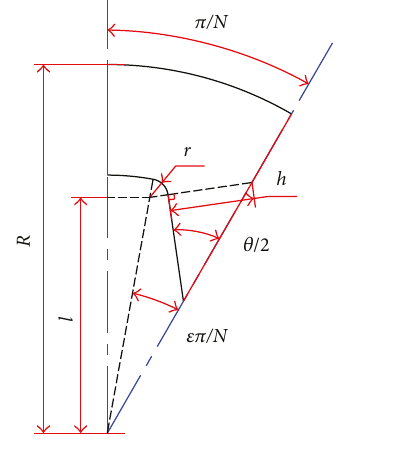
Figure 10: Geometric parameters of star grain. Table 4: Average relative error at various